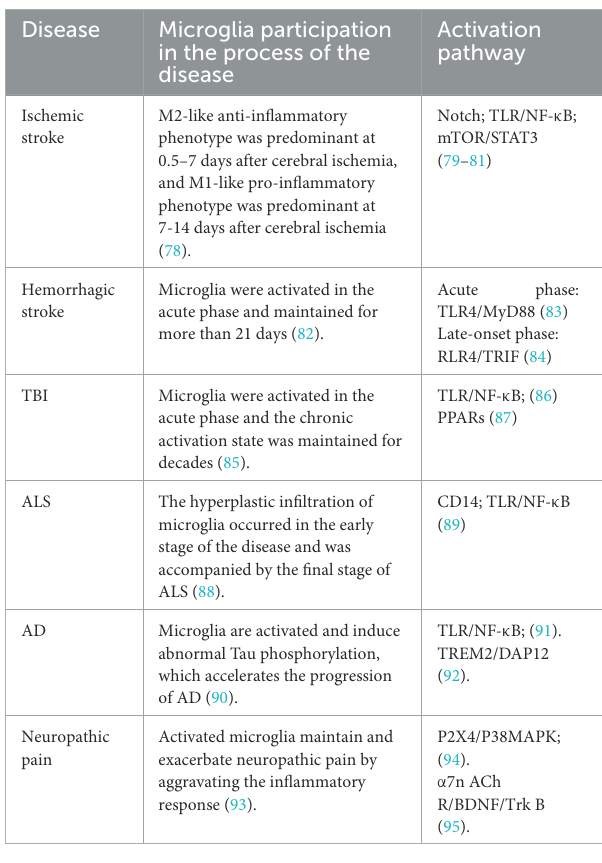
TABLE 1 Involvement of microglia in CNS